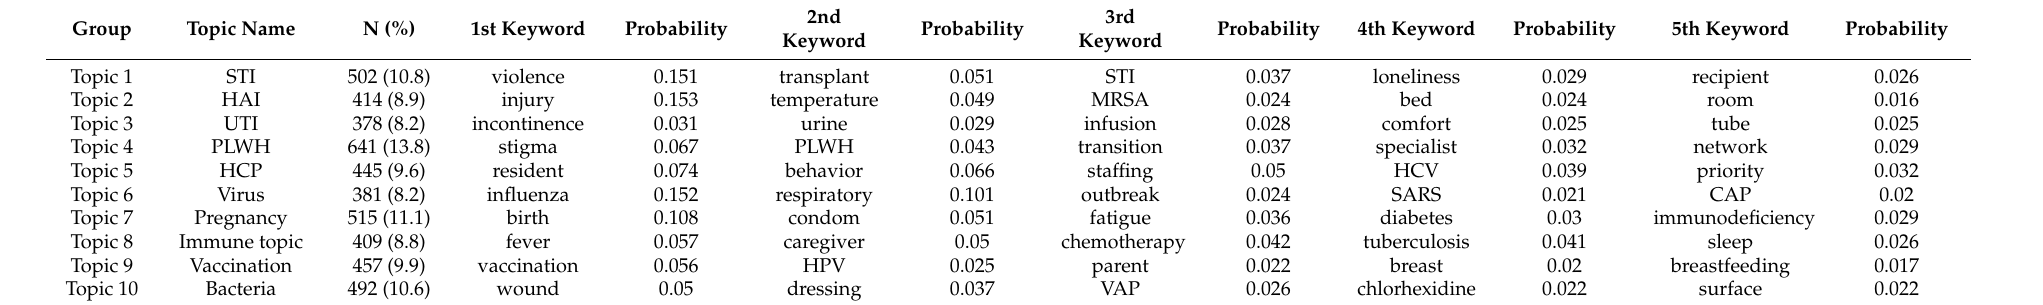
Table 4. Topic group and high ranking keywords. (n =